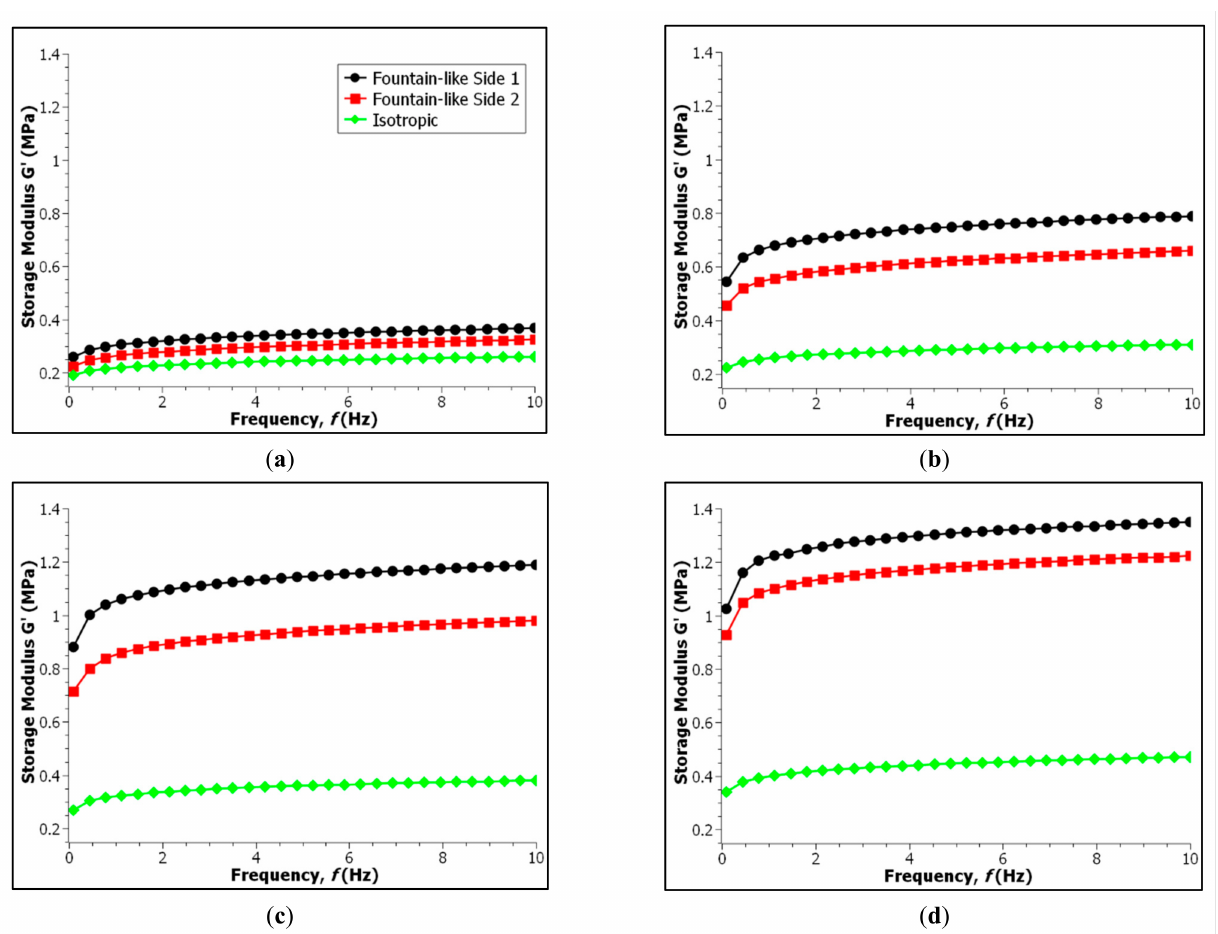
Figure 8. Storage modulus of MRE samples as a function of excitation frequencies: ( a ) at the off-state